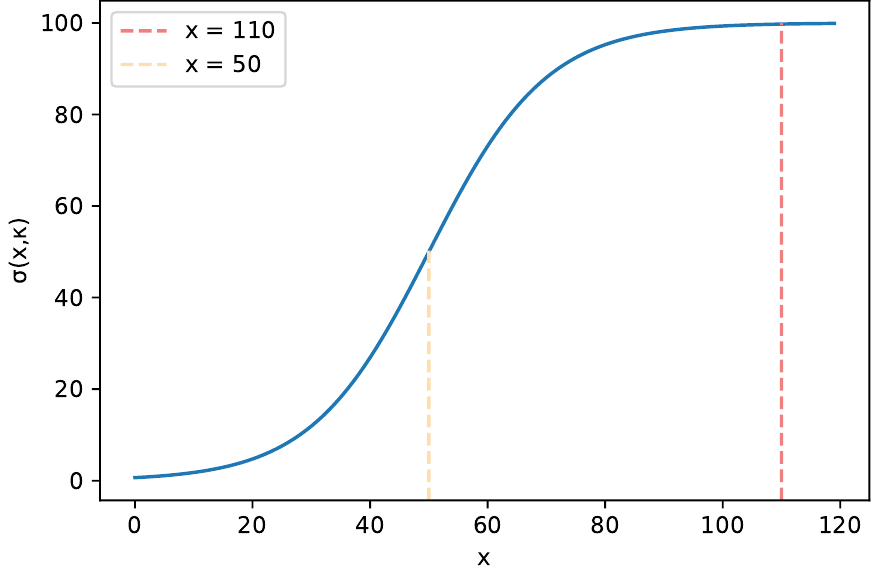
Figure 2. Plot of the σ function for κ = 100. The function returns high penalties for values x that are close to or beyond the maximum sensitivity specified by κ